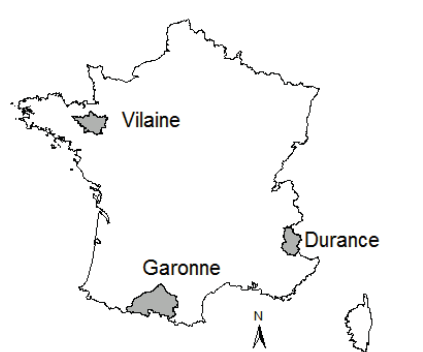
Fig. 2 Location of the three